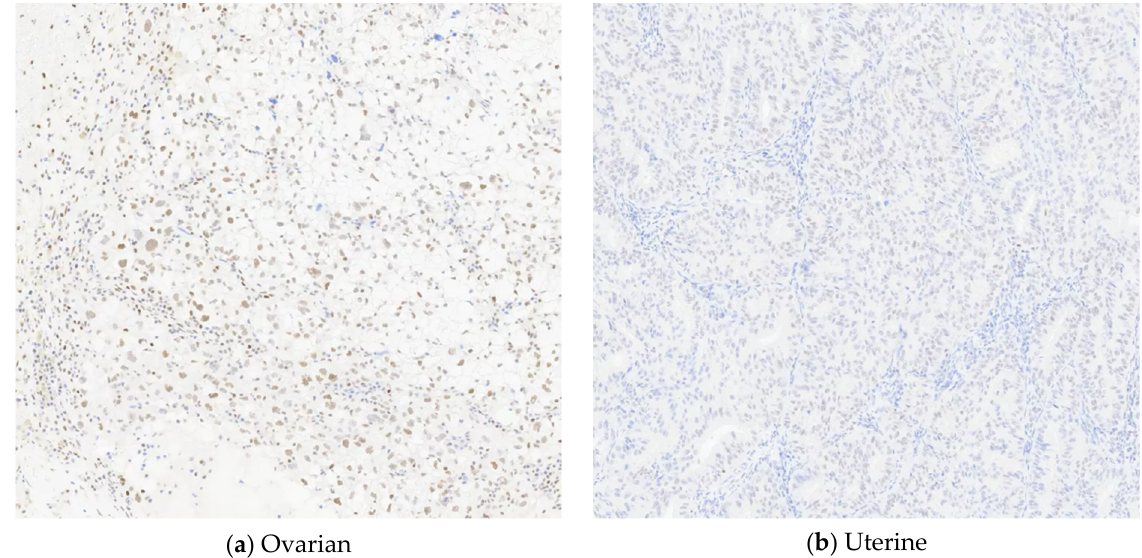
Figure 3. PMS2 (A16-4) immunohistochemical staining was intact for the ( a ) ovarian tumor and weak for the ( b ) uterine tumor.